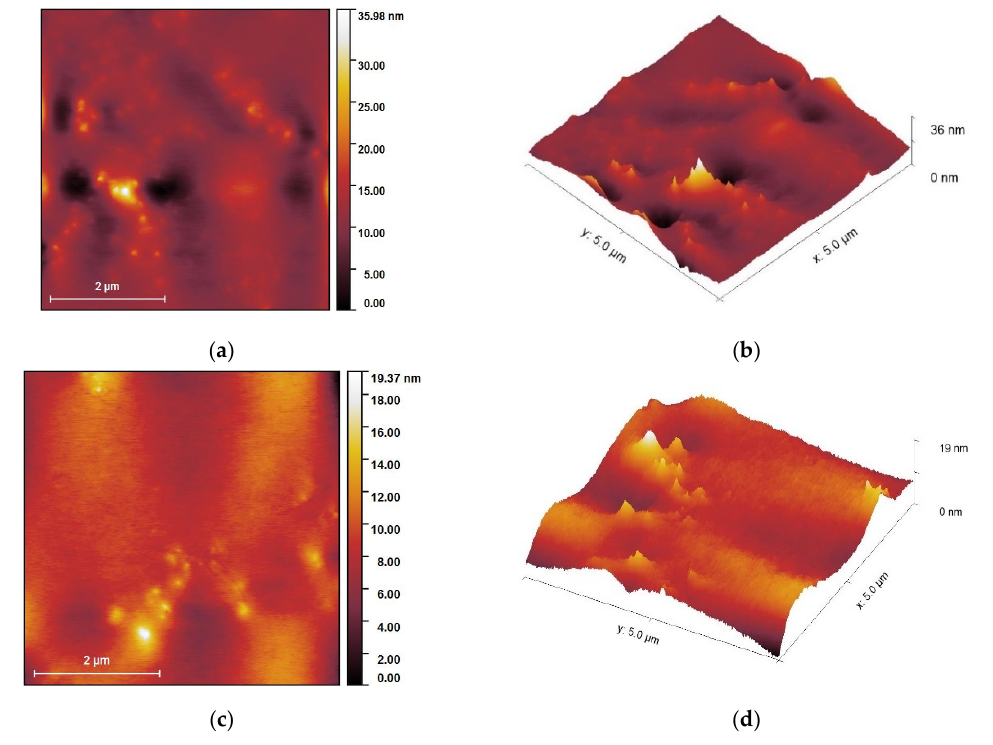
Figure 9. Morphological characterization of pectin-coated nanoparticles: MNT-nAg-PCT ( a , b ) and AMT-nAg-PCT ( c , d ): topography ( a , c ); and three-dimensional ( b , d ) AFM images.